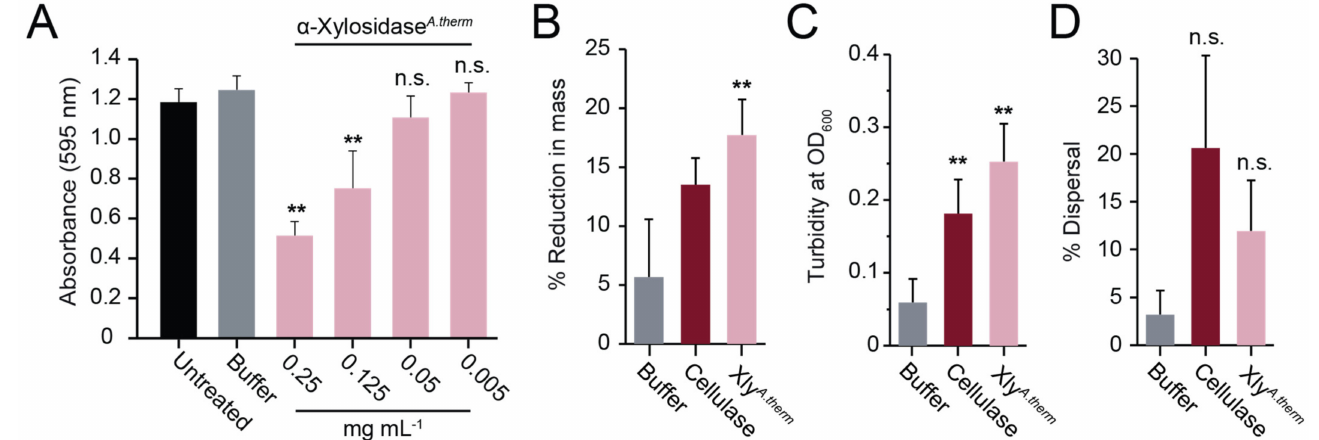
Figure 5. Purified α -xylosidase from A. thermomutatus disperses S. aureus biofilms. ( A ) S. aureus biofilms grown on polystyrene were treated with purified α -xylosidase A.therm and stained with crystal violet ( n = 3). In the Lubbock chronic wound biofilm model, purified α -xylosidase and commercial cellulase were assayed for ( B ) a reduction in biofilm mass, ( C ) an increase in turbidity, and ( D ) the dispersion of viable S. aureus cells. Significance was determined relative to the buffer control (Tukey’s test, ** p < 0.01) ( n =